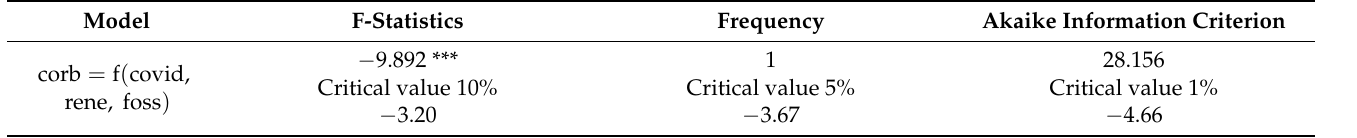
Table 3. Results of Fourier autoregressive distributed lag cointegration